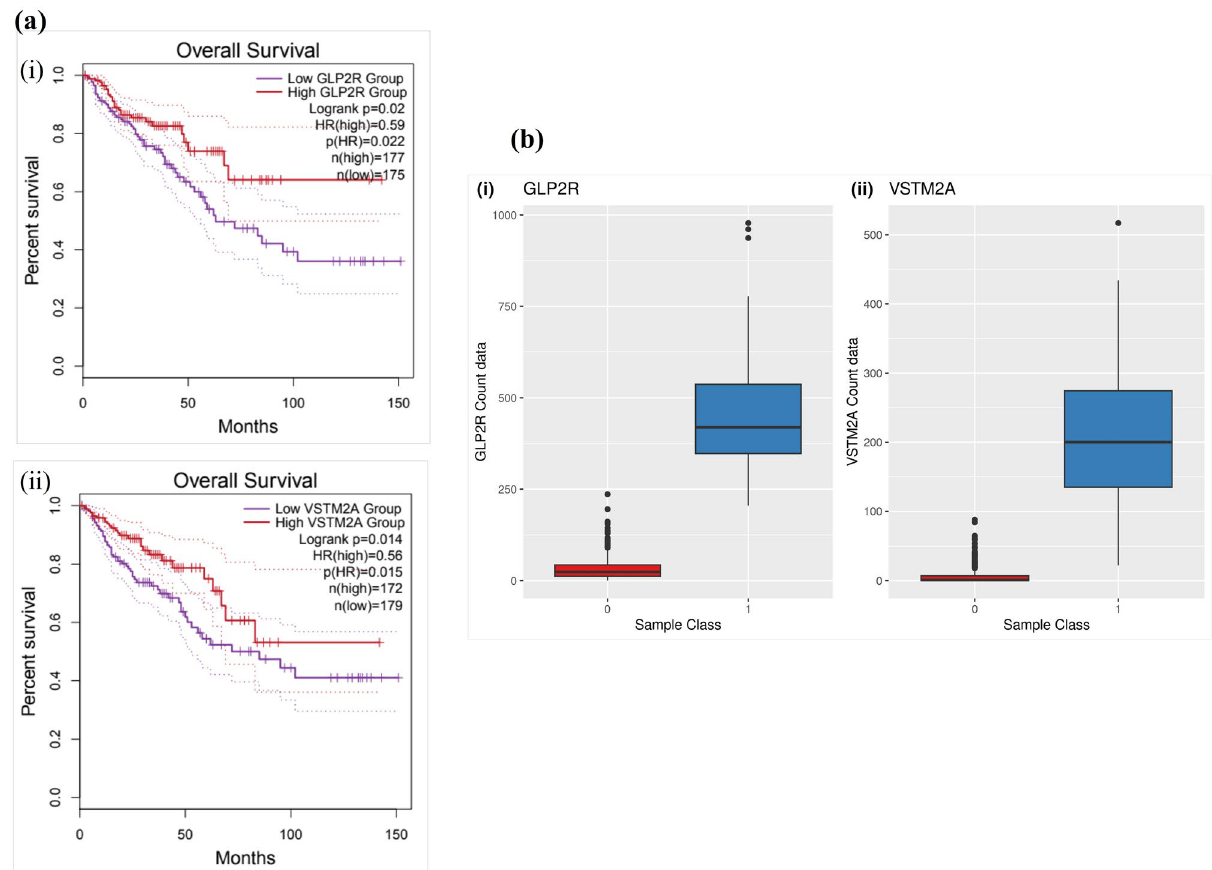
Figure 5. Overall survival analysis and gene expression profiling of CRC samples. ( a ) Kaplan–Meier plot for overall survival analysis of GLP2R and VSTM2A genes between low risk and high-risk groups having log-rank value p < 0.05, and ( b ) Gene expression analysis for GLP2R and VSTM2A genes from the TCGA-CRC dataset. The blue color denotes the normal tissue samples while the red color denotes the tumor tissue